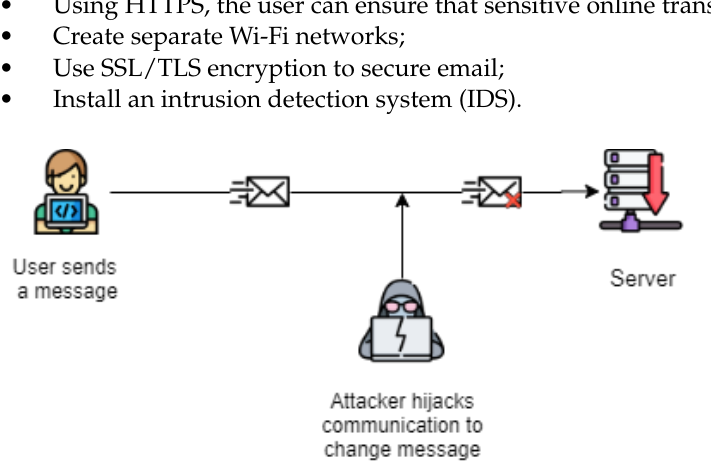
Figure 12. Graphical representation of a man-in-the-middle attack